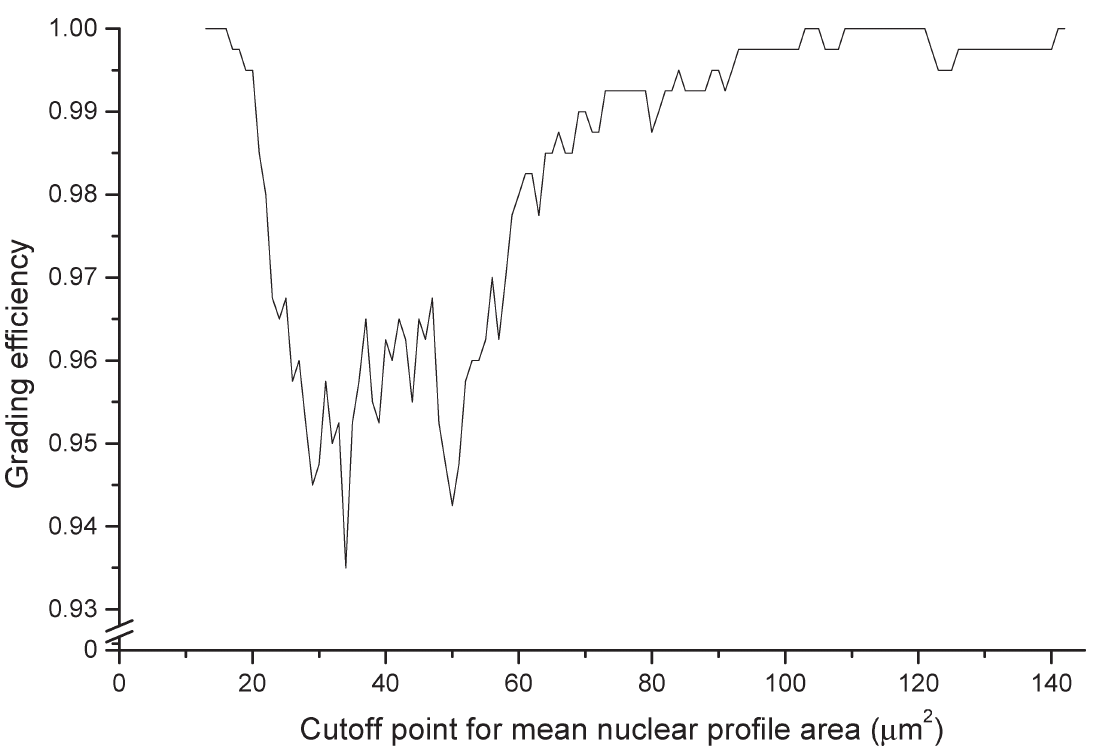
Table 5 Kappa coefficients of the morphometrically determined mean nuclear profile area (standard deviation of nuclear profile area in brackets). In the material of 192 breast cancer samples the two observers performed the measurements once. The thresholds for classifying the material into two groups were 35 µ m 2 for mean nuclear profile area and 10 µ m 2 for standard deviation of nuclear profile area. The corresponding thresholds for classifying the material into three groups were 30 µ m 2 and 40 µ m 2 , and 7 µ m 2 and 13 µ m 2 for mean nuclear area and standard deviation (SD) of nuclear profile area, respectively. Before the measurement of the above cases, 20 breast cancer samples were used for training in two phases. The latter measurements were performed twice by each observer Single measurements Repeated measurements by two observers by one observer (interobserver reproducibility) (intraobserver reproducibility) 192 breast cancer cases Two groups 0.68 (0.53) – Three groups 20 breast cancer cases Primary training phase ( n =